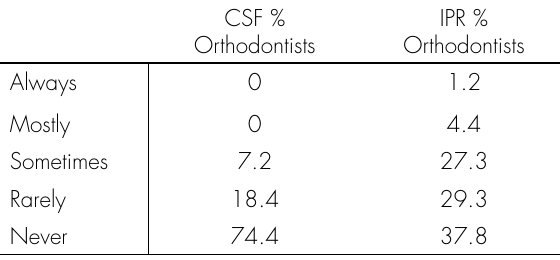
Table IV. Adjunctive retention procedures by orthodontists.